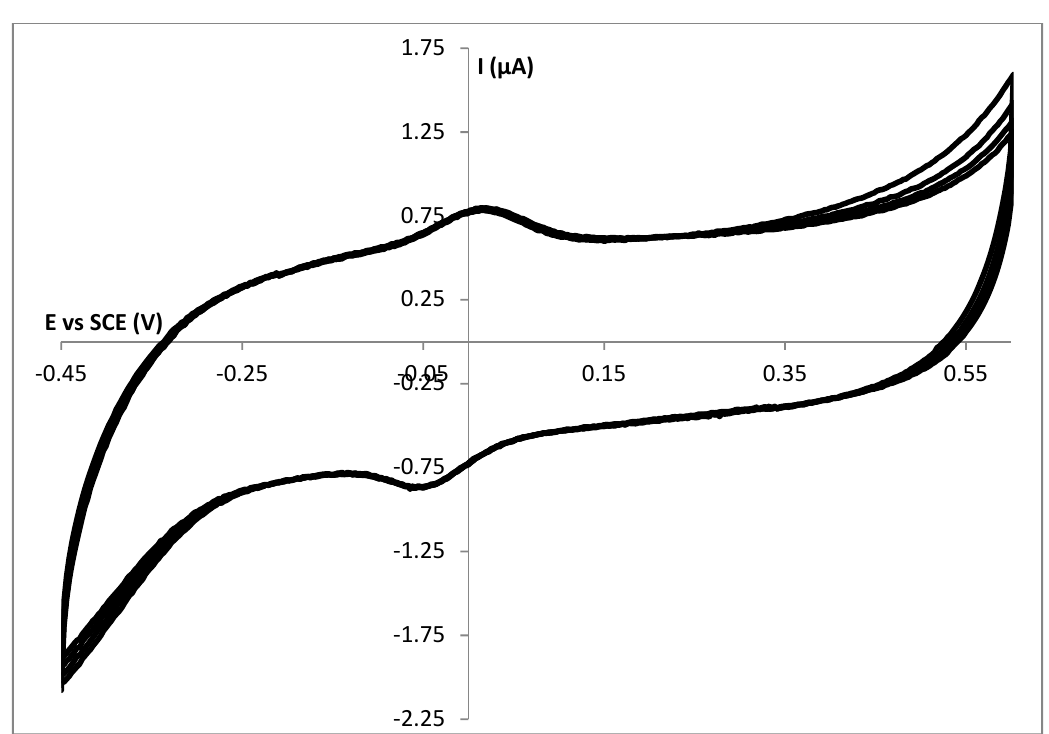
and the scan rate for a spin coated p